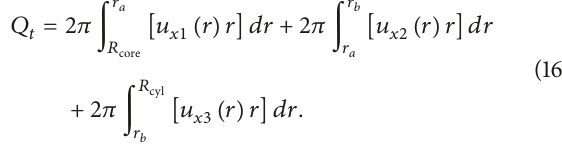
Figure 7: Optimized design parameters using Newton–Raphson